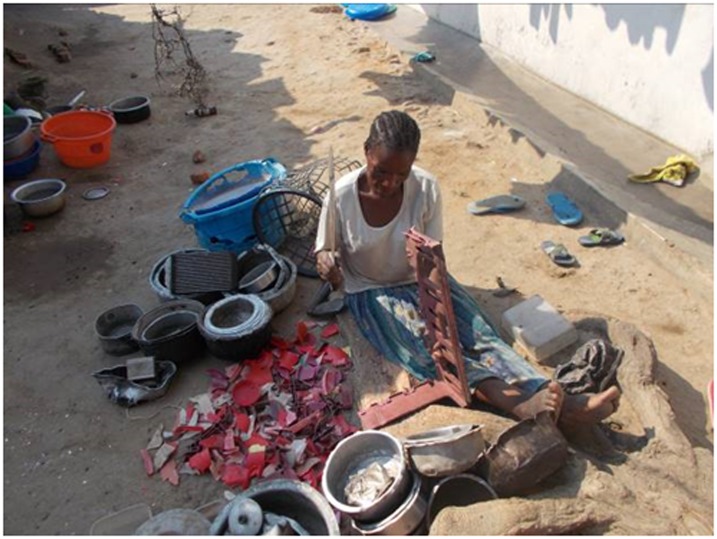
Help from Tiyanjane.